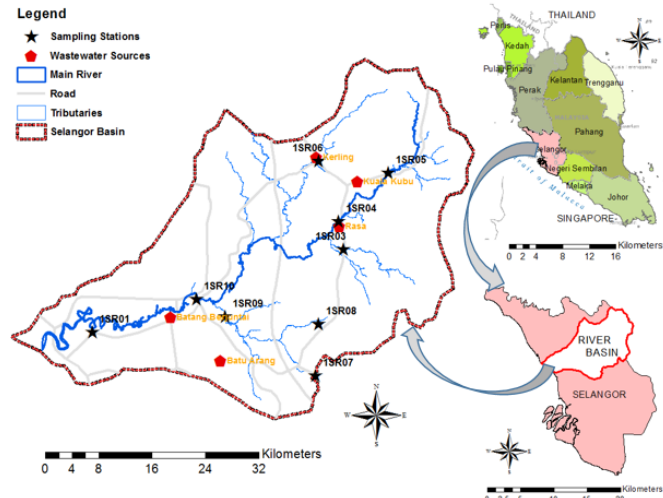
Fig. 1: Geographic location of the study area along with the sampling points in Selangor, Malaysia